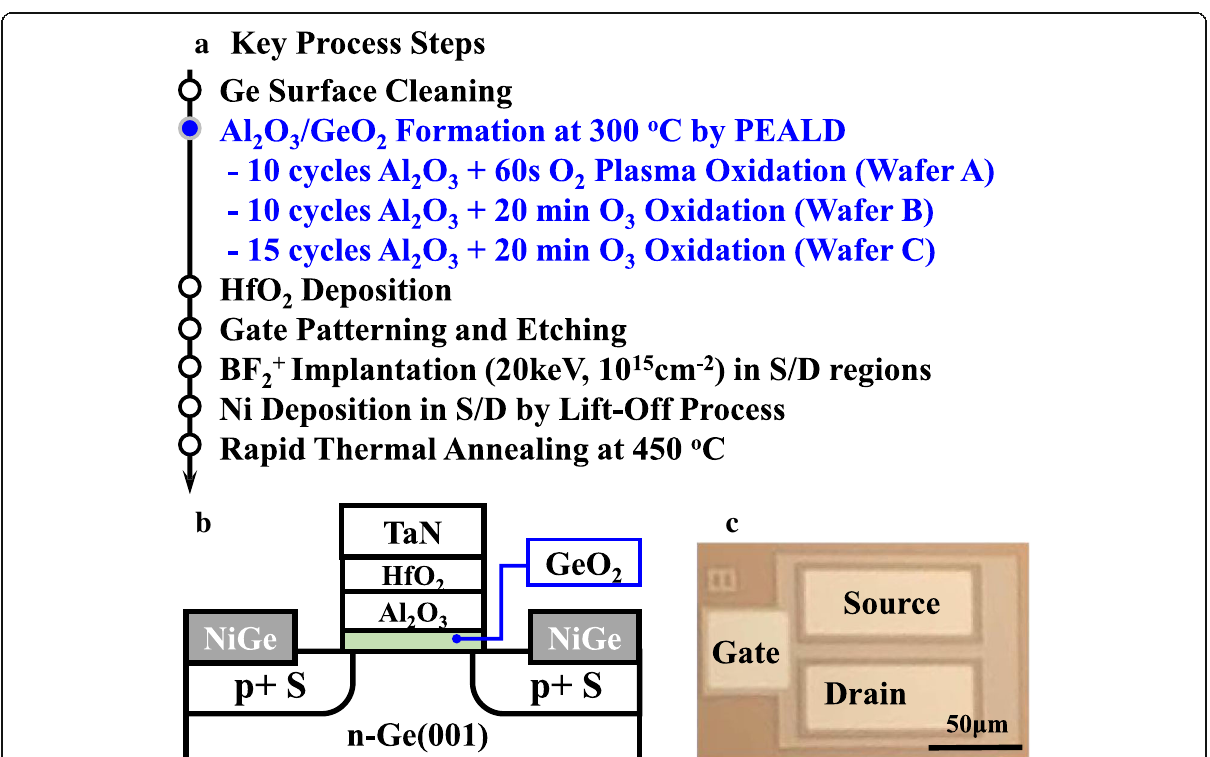
Fig. 1 a Key process flow for fabricating Ge pMOSFETs with GeO 2 surface passivation with three different passivation methods. b Schematic and c microscope images of the fabricated Ge transistor